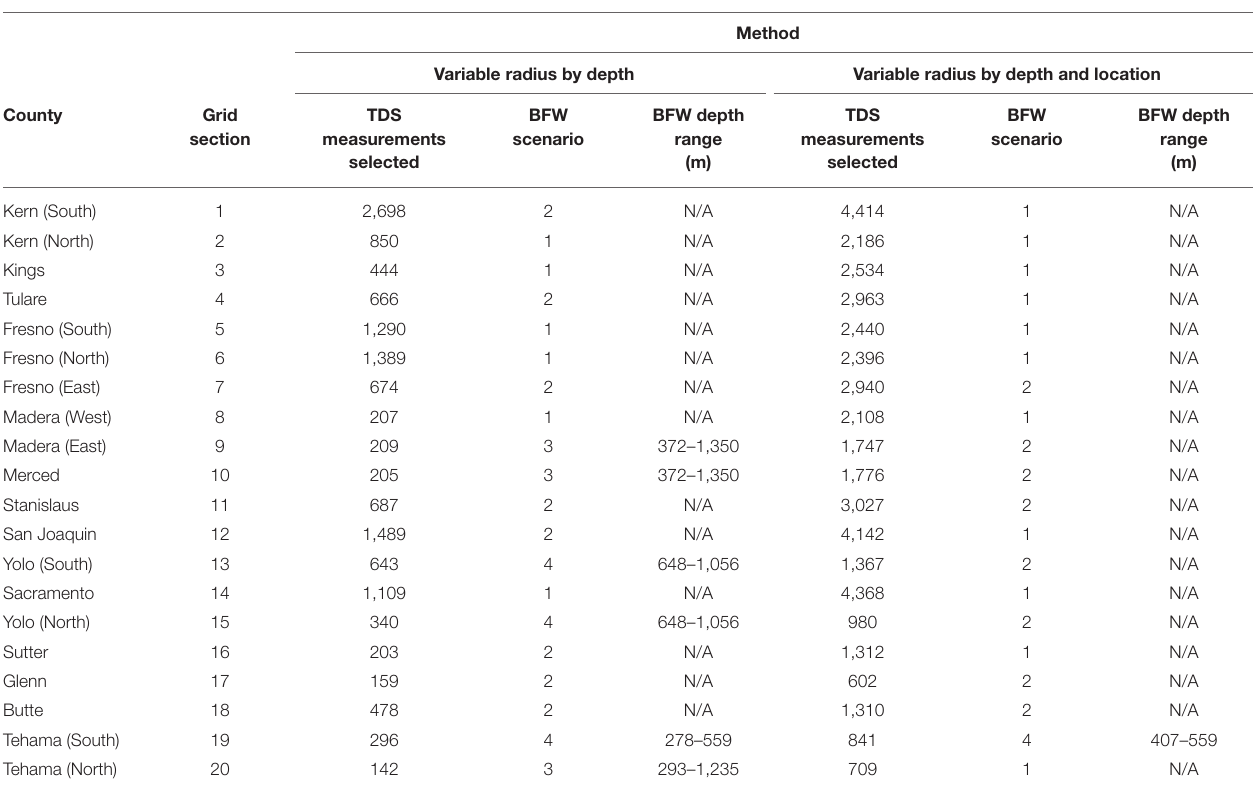
TABLE 1 | Number of selected TDS measurements and ability to determine BFW for each of the 20 selected grid sections using selection methods that have a variable radius.